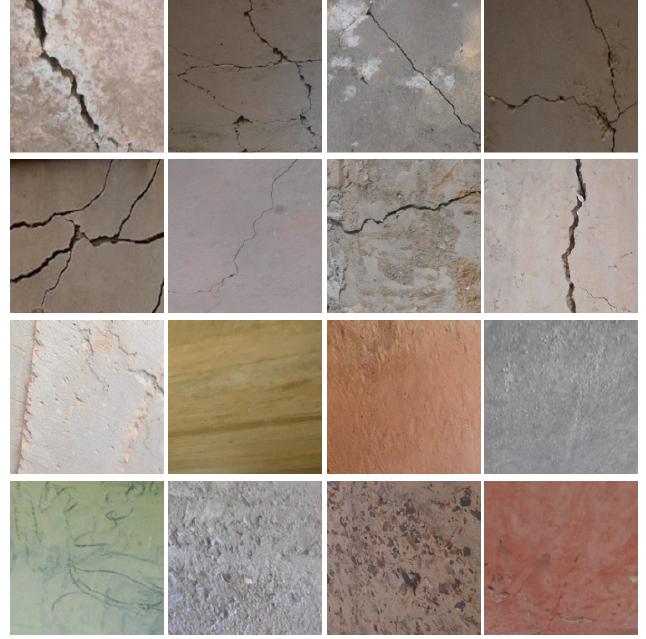
Figure 5. Sample images of the studied dataset: Rows (1) and (2) present different patterns of cracks in concrete; rows (3) and (4) present different representations of concrete surfaces. Table 1. HOG, ULBP, and KPCA